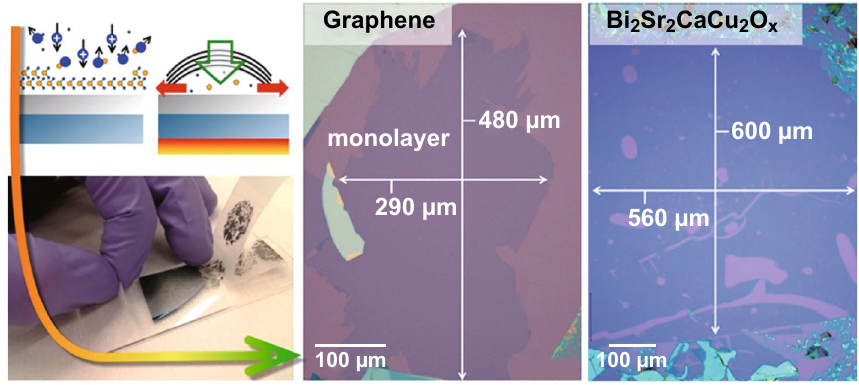
Fig. 15 ME isolation of graphene. Schematic illustration of a modified ME route and optical images of the isolation of the large-area graphene and BSCCO monolayers using the same technique, respectively. In this technique, the SiO 2 /Si surface was cleaned with O 2 plasma, followed by annealing and peel-off. Adapted with permission from Ref. [20]. Copyright 2015, American Chemical